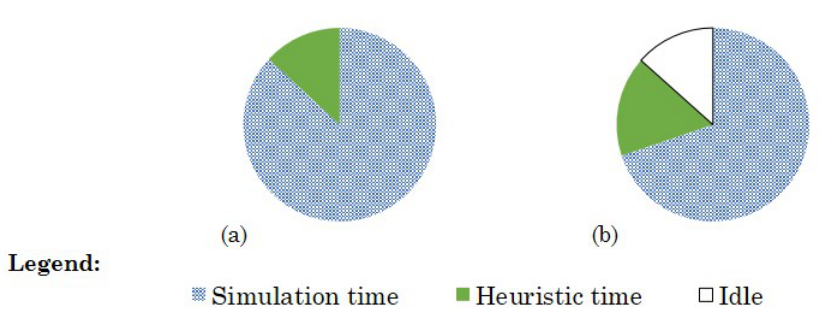
Figure 9. The time distribution in ( a ) a reference EA experiment and ( b ) an EA experiment utilising the equivalent action plans